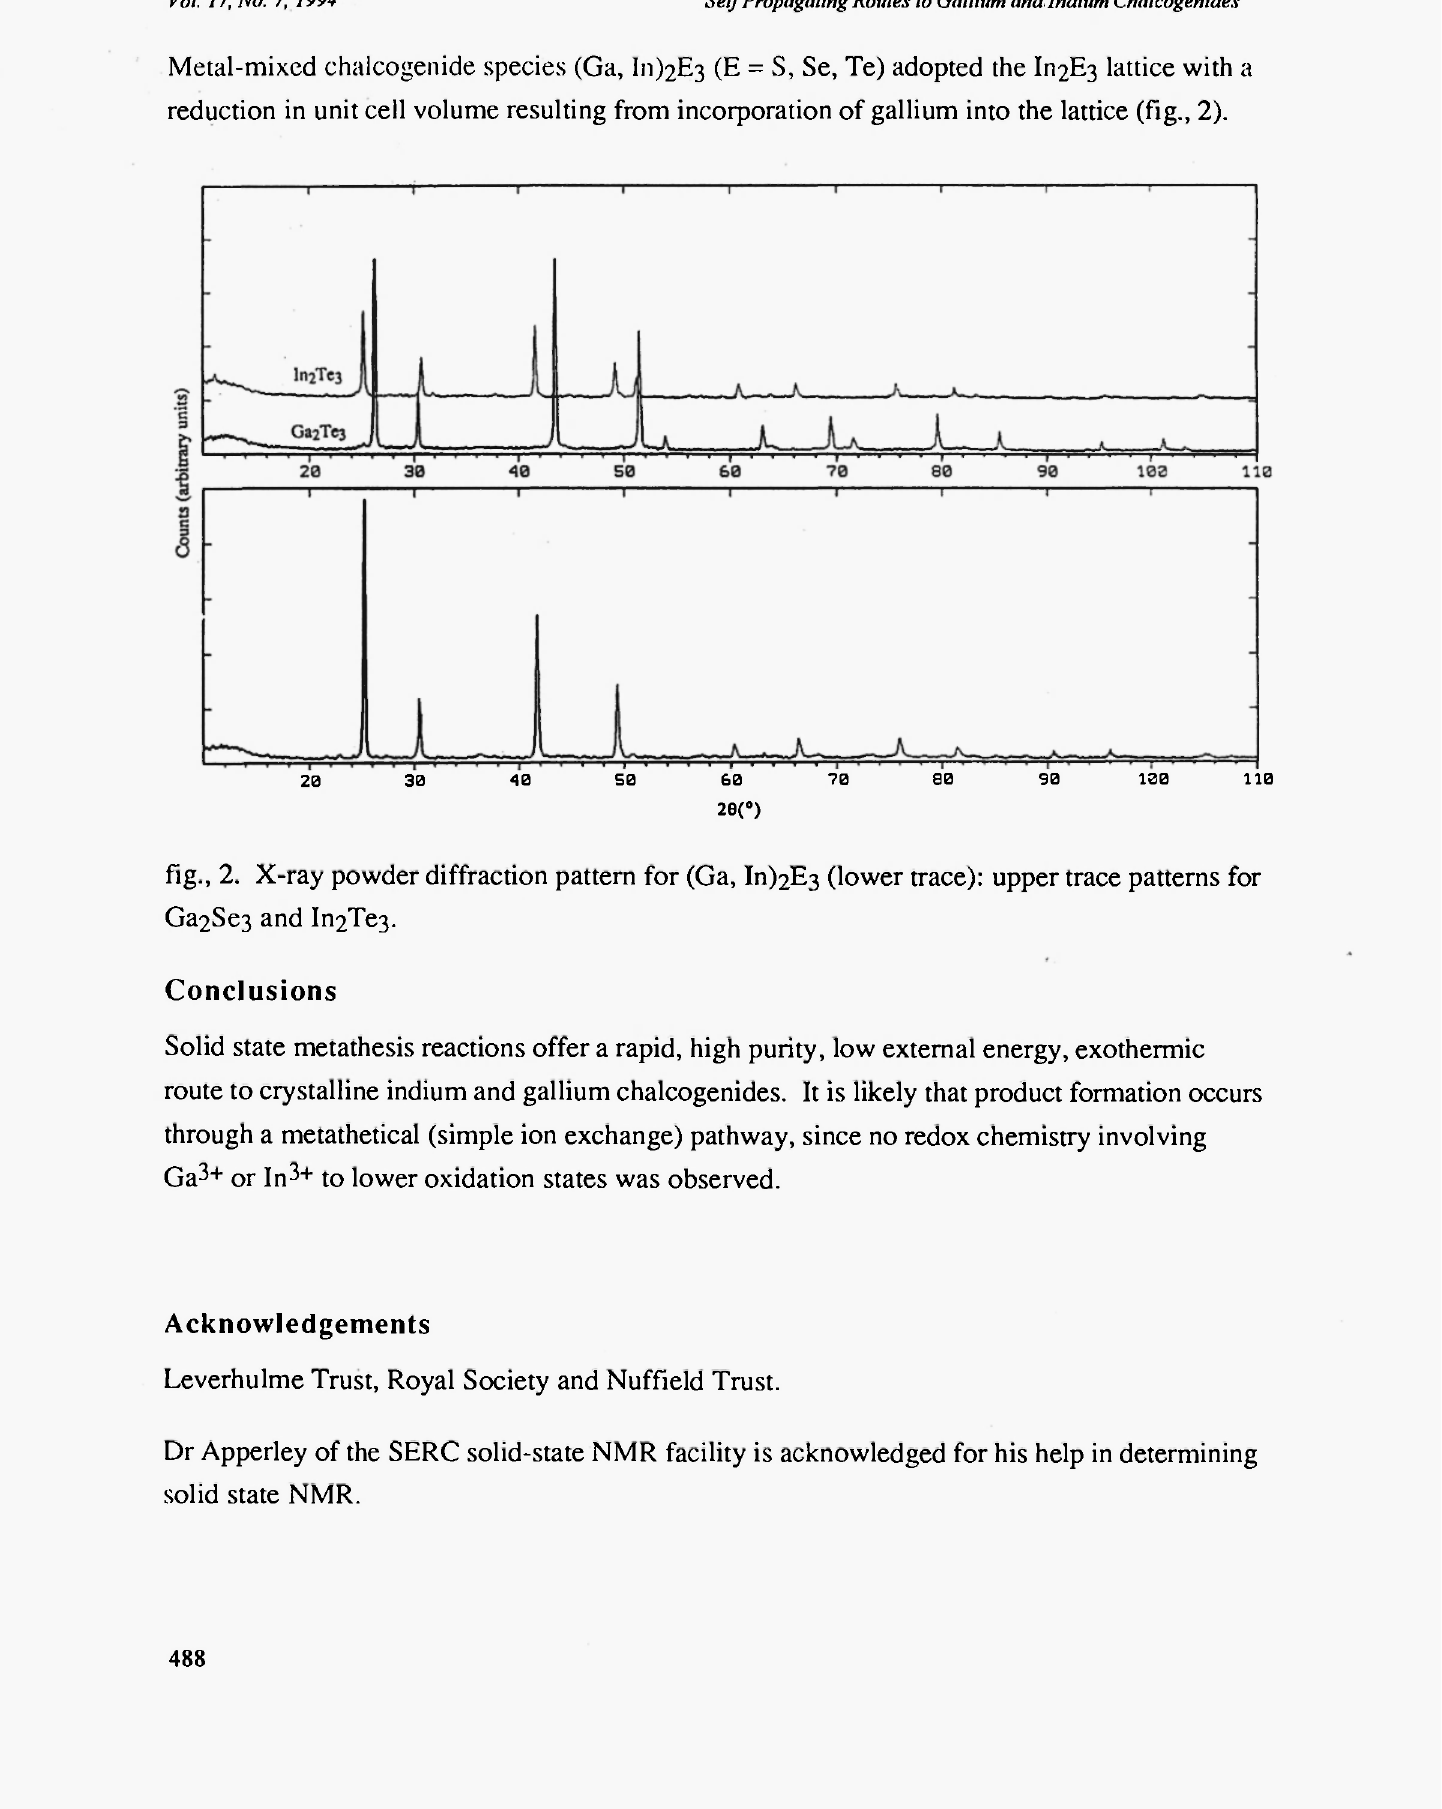
fig., 2. X-ray powder diffraction pattern for (Ga, Ιη^Εβ (lower trace): upper trace patterns for Ga2Se3 and